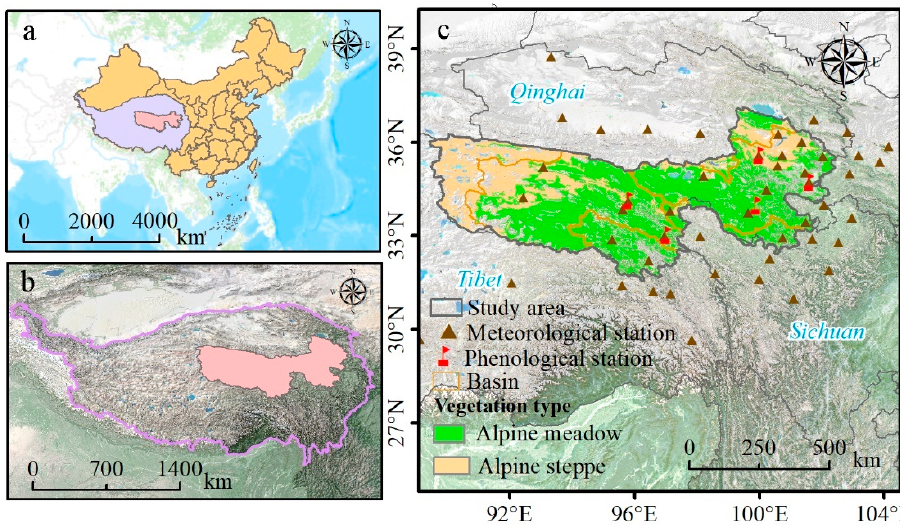
Figure 2. Maps of the study area: ( a ) Tibetan Plateau in China; ( b ) Three-River Headwaters region on the Tibetan Plateau; ( c ) locations of meteorological, phenological stations, alpine steppe, and alpine meadow in and near the Three-River Headwaters region.